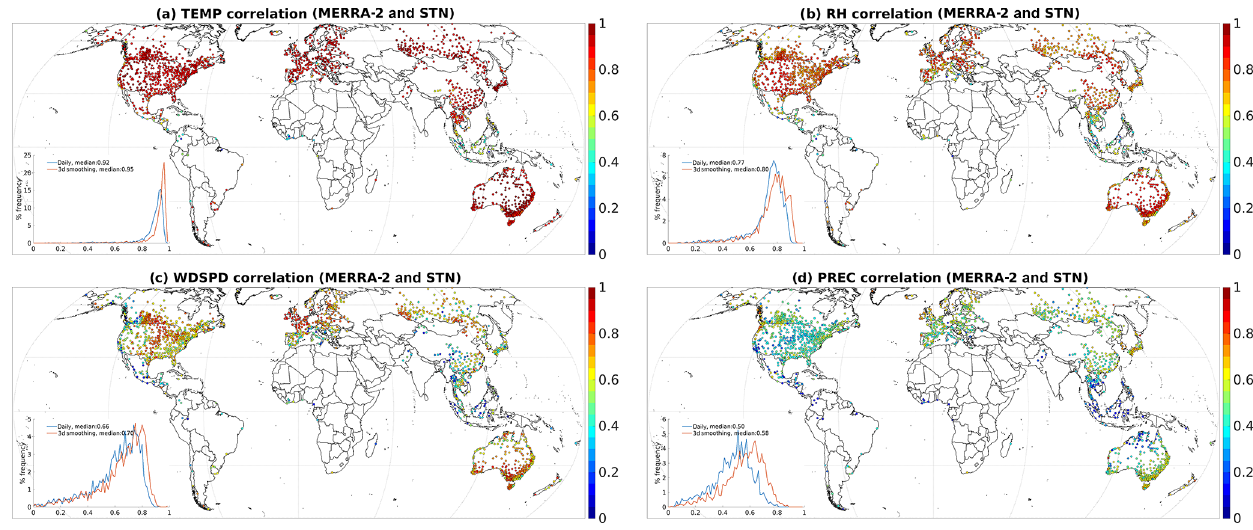
Figure 8. Same as Fig. 7 but for input weather